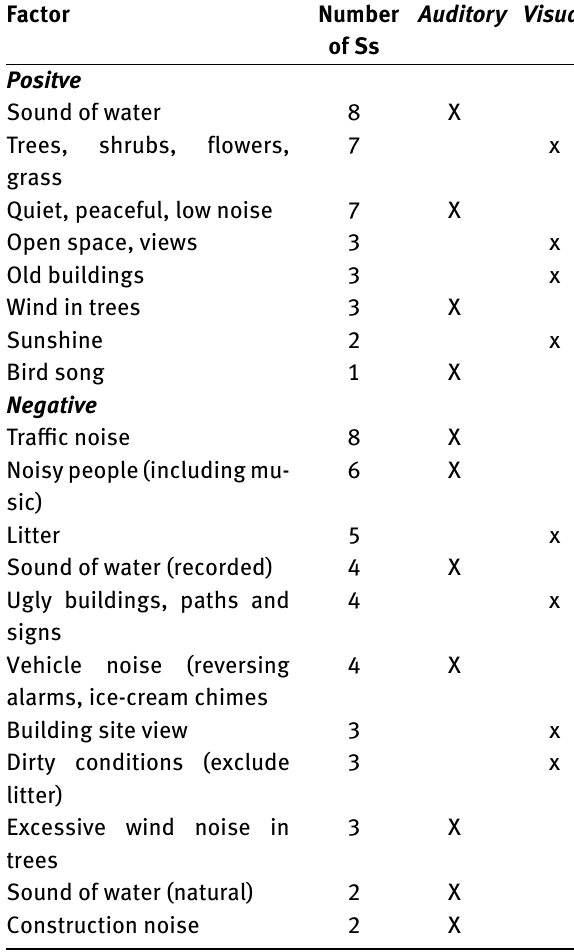
Table 3: Positive and negative factors affecting